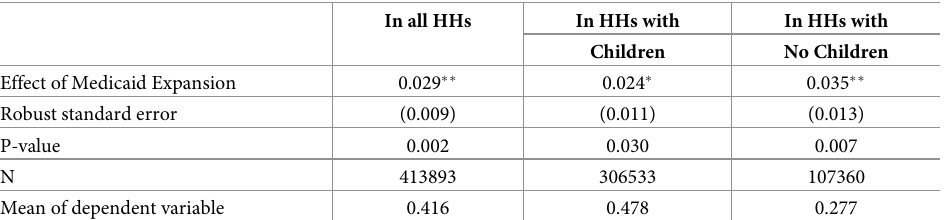
Table 1. ACA Medicaid expansion effects on SNAP receipt by household composition.